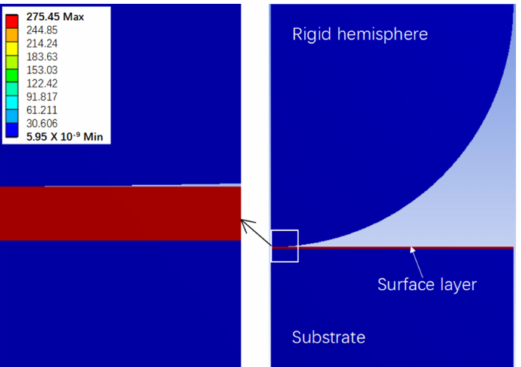
Figure 4. Residual stress field induced in surface layer by thermal mismatch.